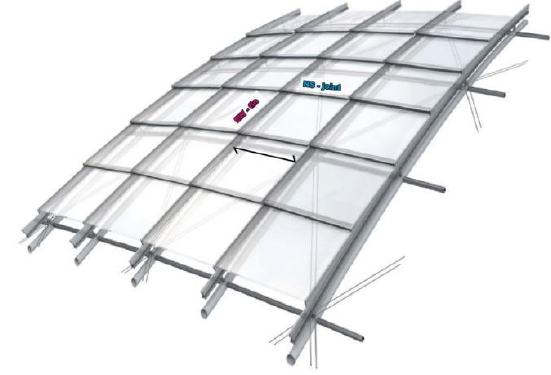
Fig. 13 3D diagram of the shingled glazing system. Image: Knippers Helbig.